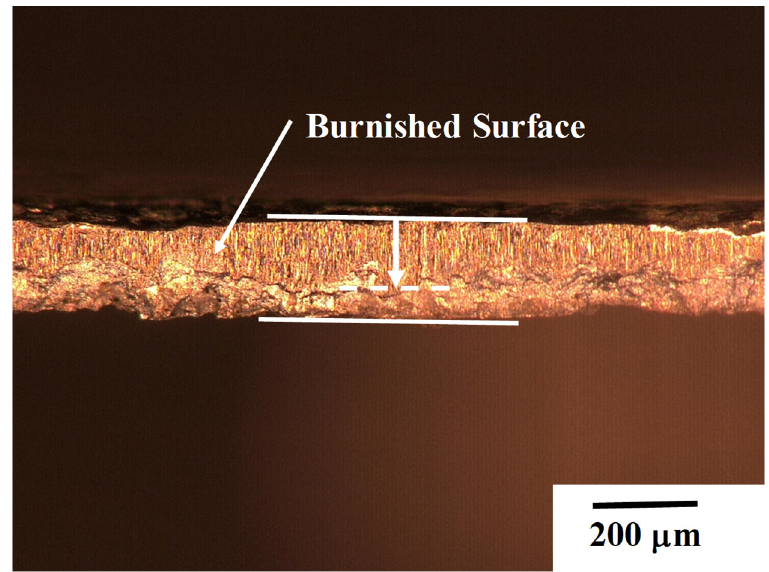
Figure 12. Optical microscopy image on the sheared surface of electrical steel sheet by the present piercing experiment with the use of as-blasted punch and